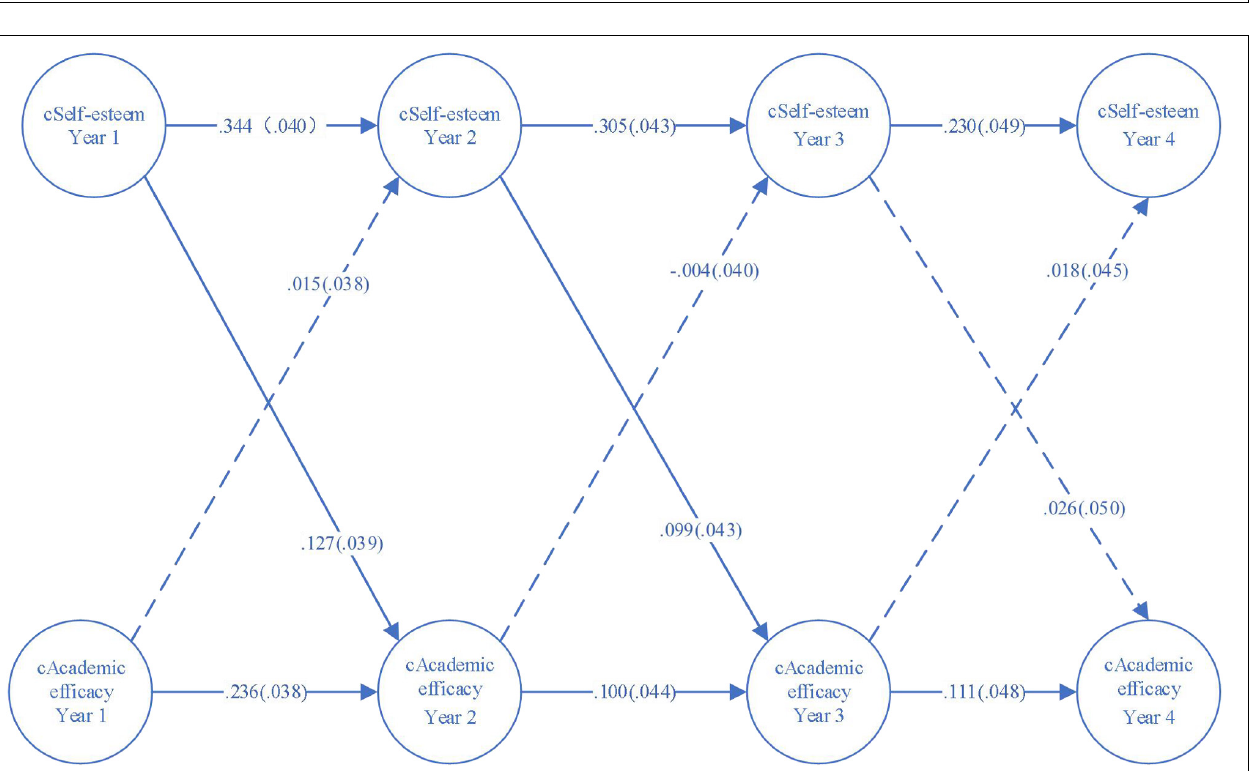
FIGURE 3 | A four-wave cross-lagged panel model with random intercepts (male